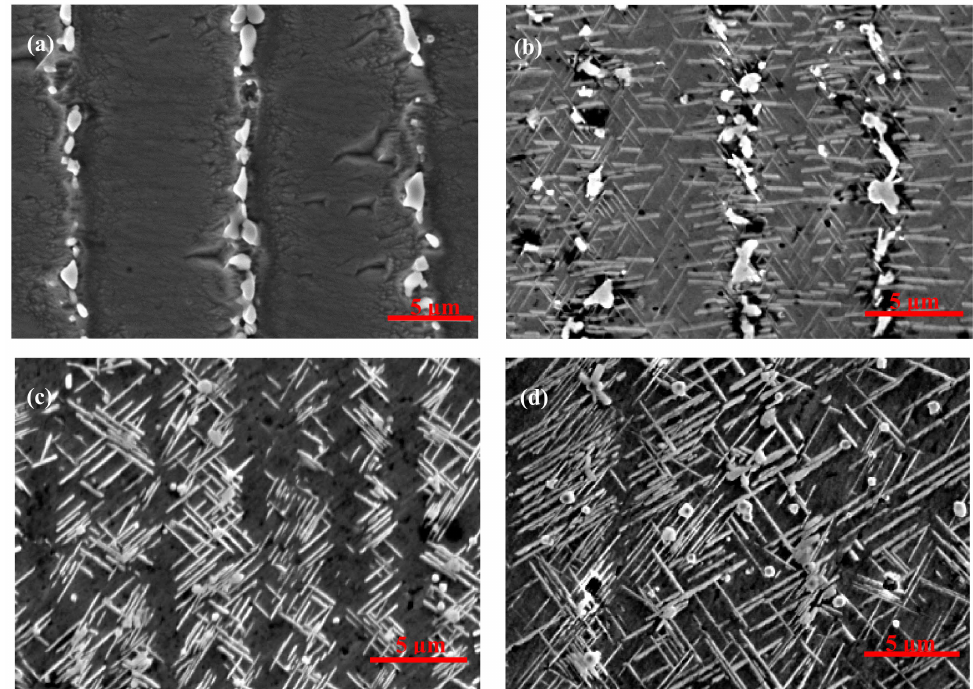
Figure 7. Morphology and distribution of the δ phase after aging at 950 ◦ C for di ff erent aging times for samples fabricated with electromagnetic stirring at 50 mT. ( a ) The as-deposited sample with 50 mT, ( b ) aging for 1 h, ( c ) aging for 4 h, and ( d ) aging for 16 h.